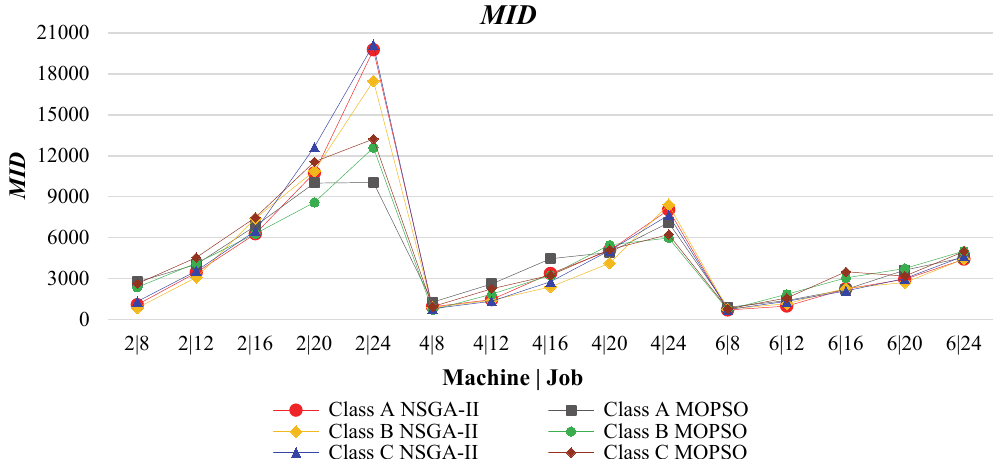
Fig. 12. MID criterion for the two algorithms in the small scale sample problems